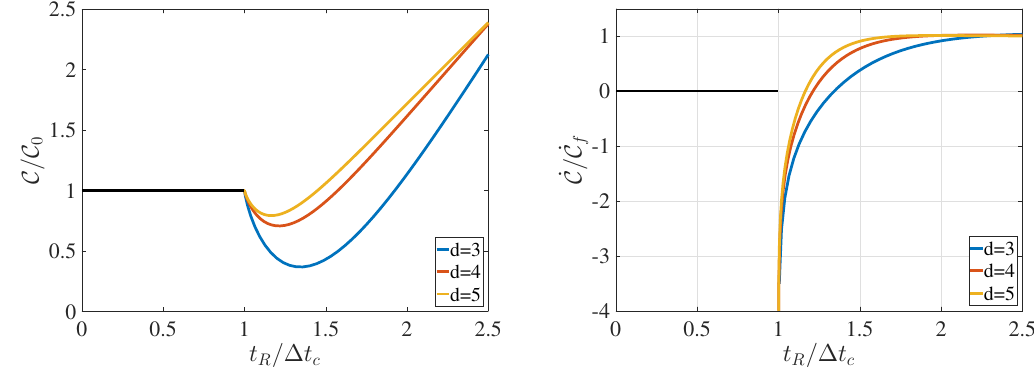
Figure 2 . The complexity C ( j TFD(0 ; t R ) i ; j 0 i ) and its growth rate when d > 2. C 0 is the